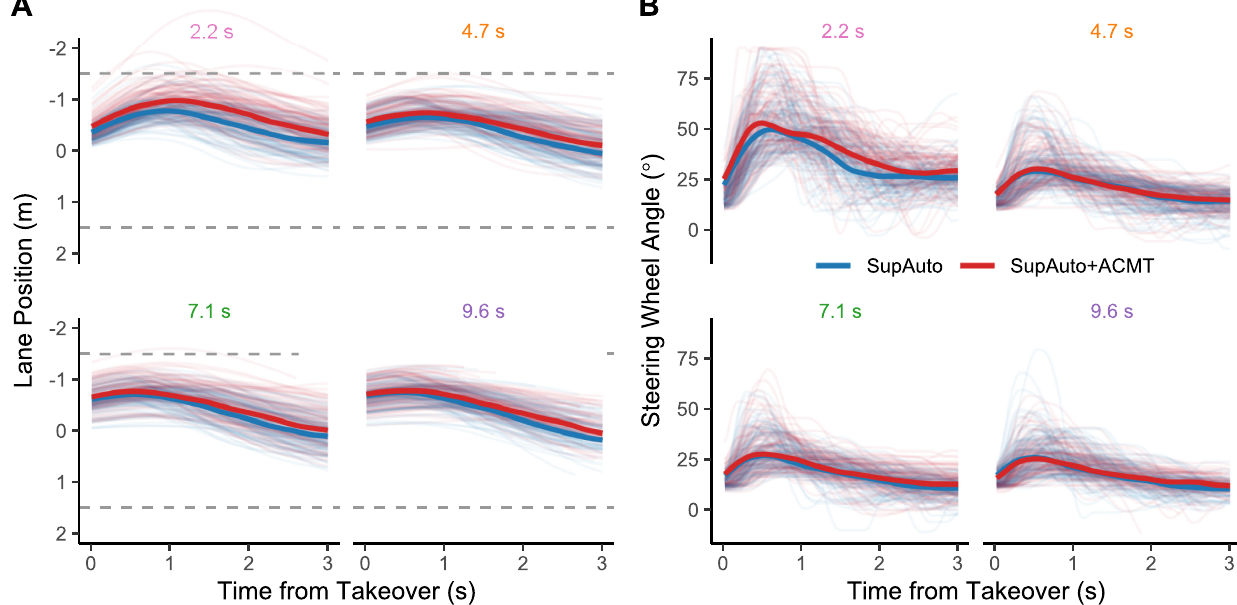
Fig 3. Steering behaviour. Individual A) Steering bias and B) Steering Wheel Angle traces for Repeated conditions for the first 3 seconds after takeover, with the rolling average (using a .25 s window) median trend line shown for SupAuto and SupAuto+ACMT shown in bold. Panel titles show TLC F , coloured as per Fig